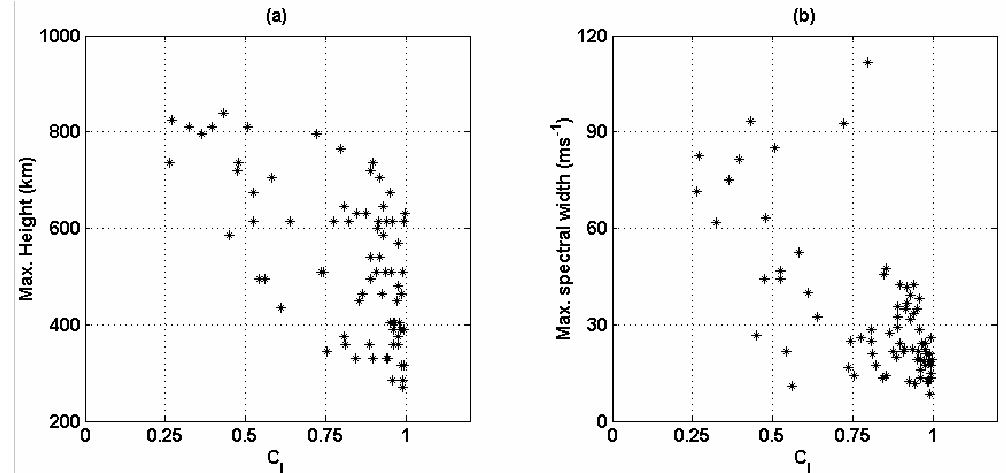
Fig. 6. Composite scatter plot of (a) maximum height of the radar backscattered echoes versus C I and (b) spectral width versus C I . spectral widths derived from radar echoes at this stage. The maximum height for the radar echoes also shows a similar pattern of variations with